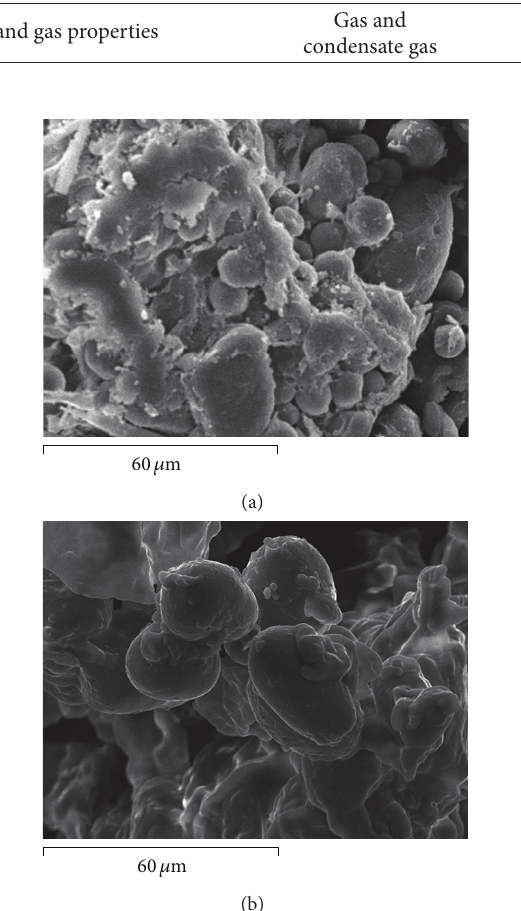
Figure 5: SEM images of special water-soluble polymer (a) and Ewax (b).